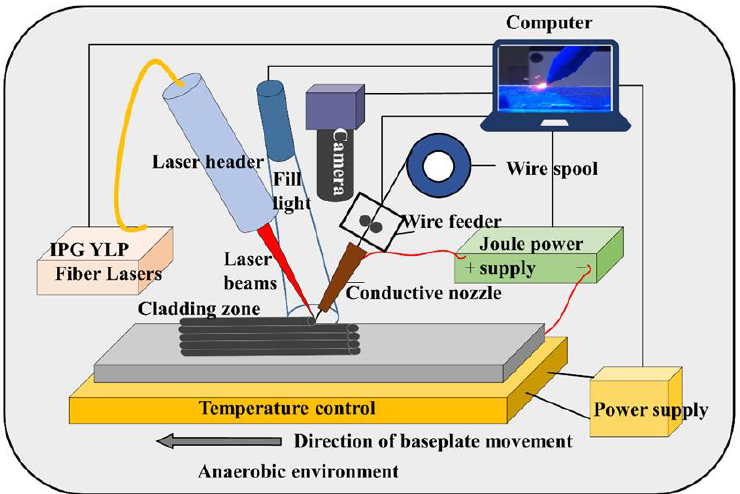
Figure 1. Schematic of the LJWF-DMD AM system.